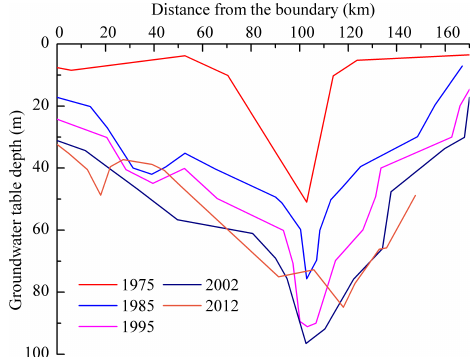
Figure 3. Changes in the water table depth of the aquifer layer III along the cross section from the west to the